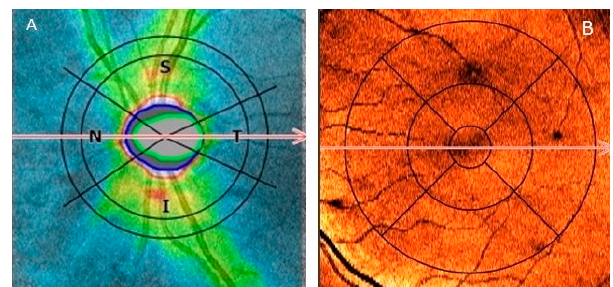
Figure 2. Representative optical coherence tomography (OCT) images of inspected regions ( A ). Po- sition of the ring scan to measure peripappilary retinal nerve fiber layer thickness with superior (S), temporalis (T), inferior (I) and nasalis (N) quadrants. ( B ). Position of the macular subfields with inner, intermediate and outer rings to calculate average macular volume.